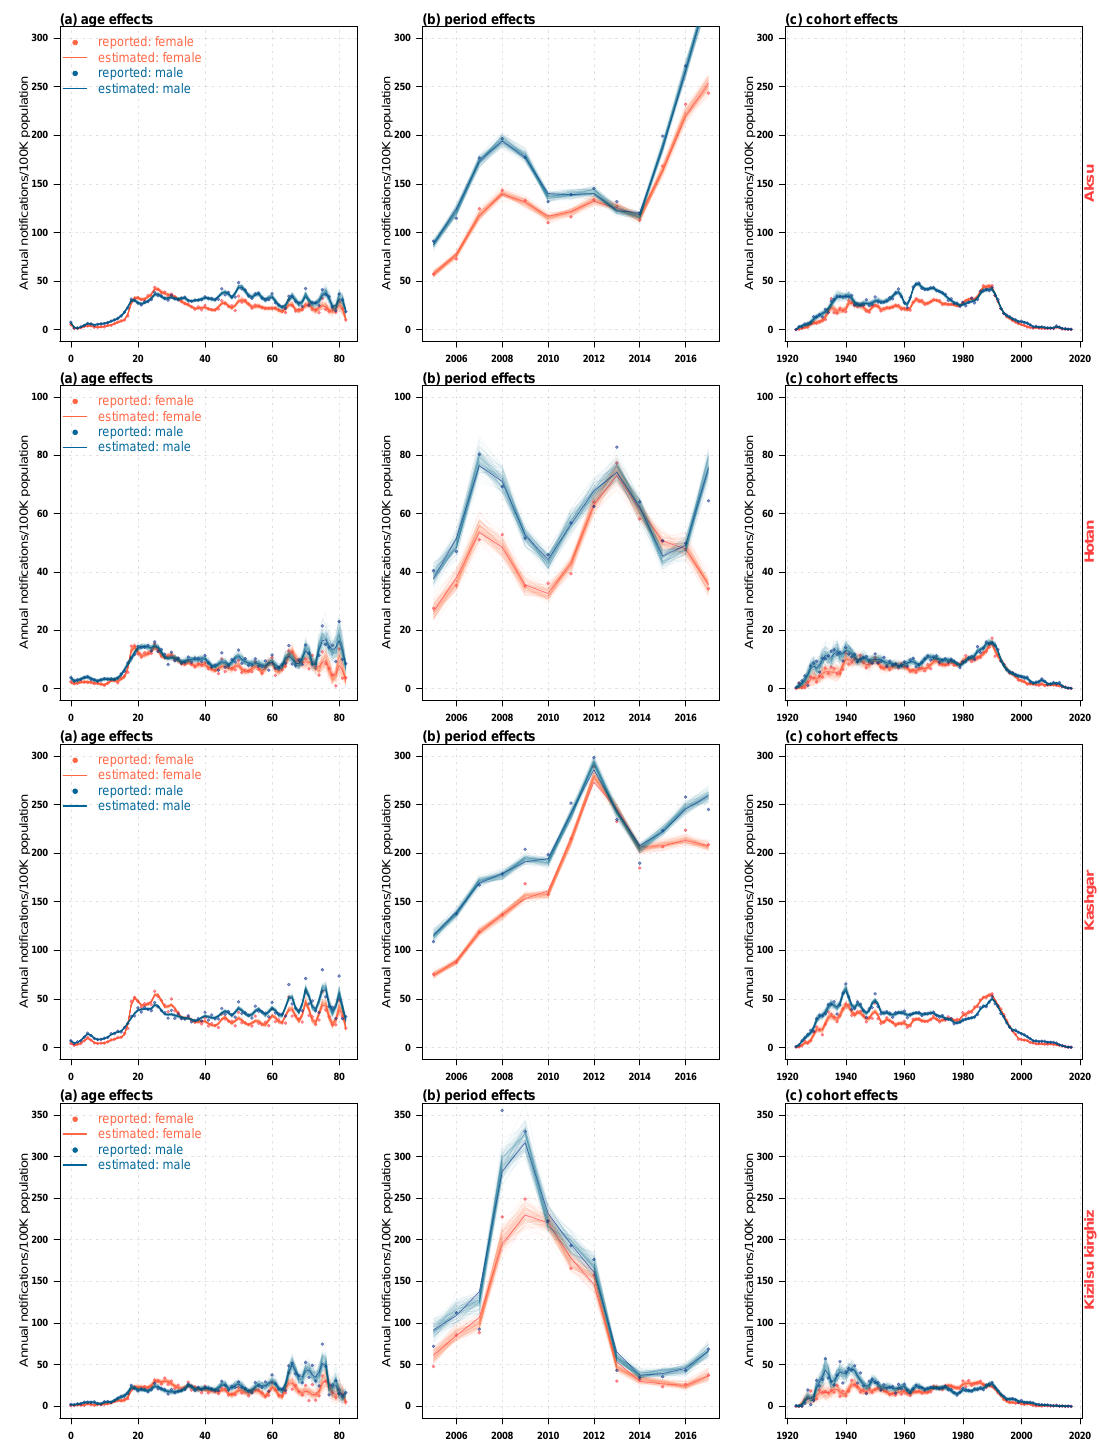
Figure 10. The estimated impact of age ( left column ), period ( middle column ) and birth cohort ( right column ) on the incidence of HB in four regions of Xinjiang from 2005 to